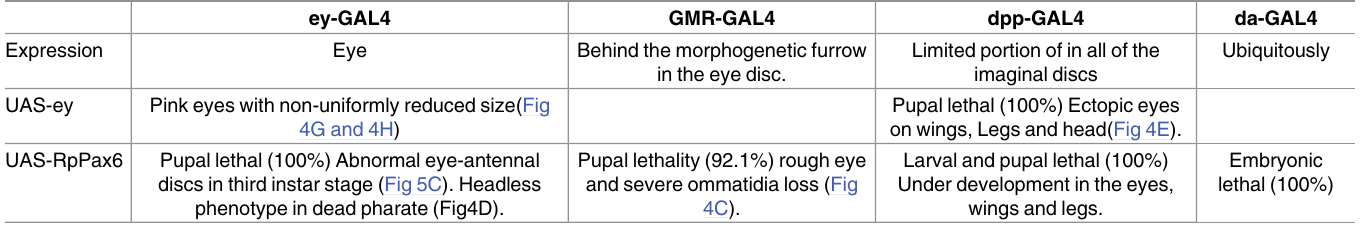
Table 1. Phenotypes associated with ectopic expressionof ey and RpPax6 . ey-GAL4 da-GAL4 Expression Eye Behind the morphogenetic furrow Limited portion of in all of the Ubiquitously in the eye disc. imaginal discs UAS-ey Pink eyes with non-uniformly reduced size(Fig Pupal lethal (100%) Ectopic eyes 4G and 4H) on wings, Legs and head(Fig 4E). UAS-RpPax6 Pupal lethal (100%) Abnormal eye-antennal Pupal lethality (92.1%) rough eye Larval and pupal lethal (100%) Embryonic discs in third instar stage (Fig 5C). Headless and severe ommatidia loss (Fig Under development in the eyes, lethal phenotype in dead pharate (Fig4D). 4C). wings and legs.